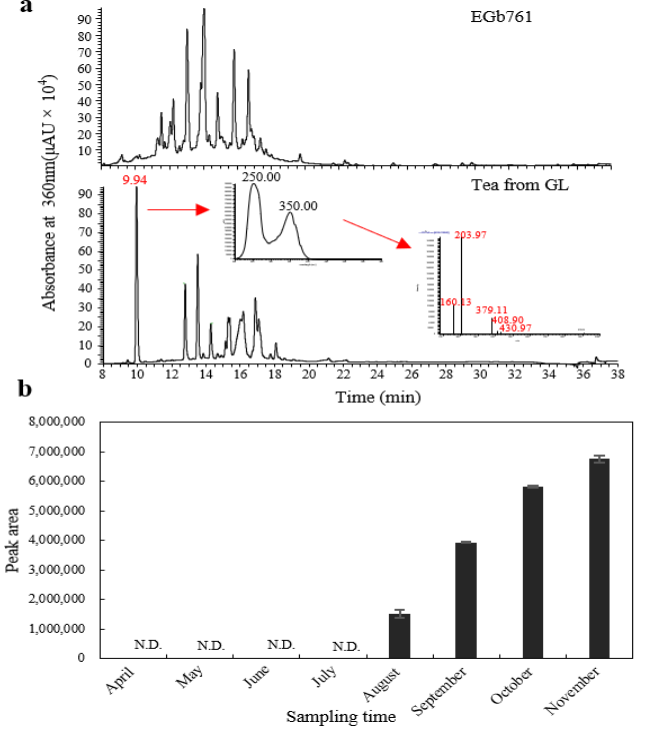
Note : U represents ultrasound-assisted extraction. Data are represented as mean (S.D.). n = 3. Different letters represent significantly different values ( p < 0.05).